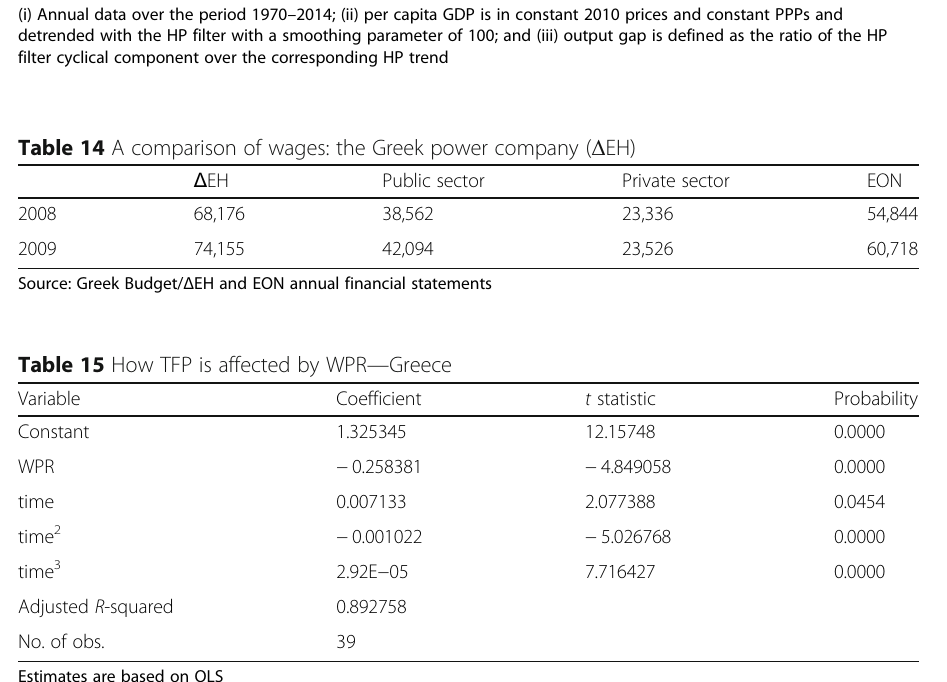
Estimates are based on